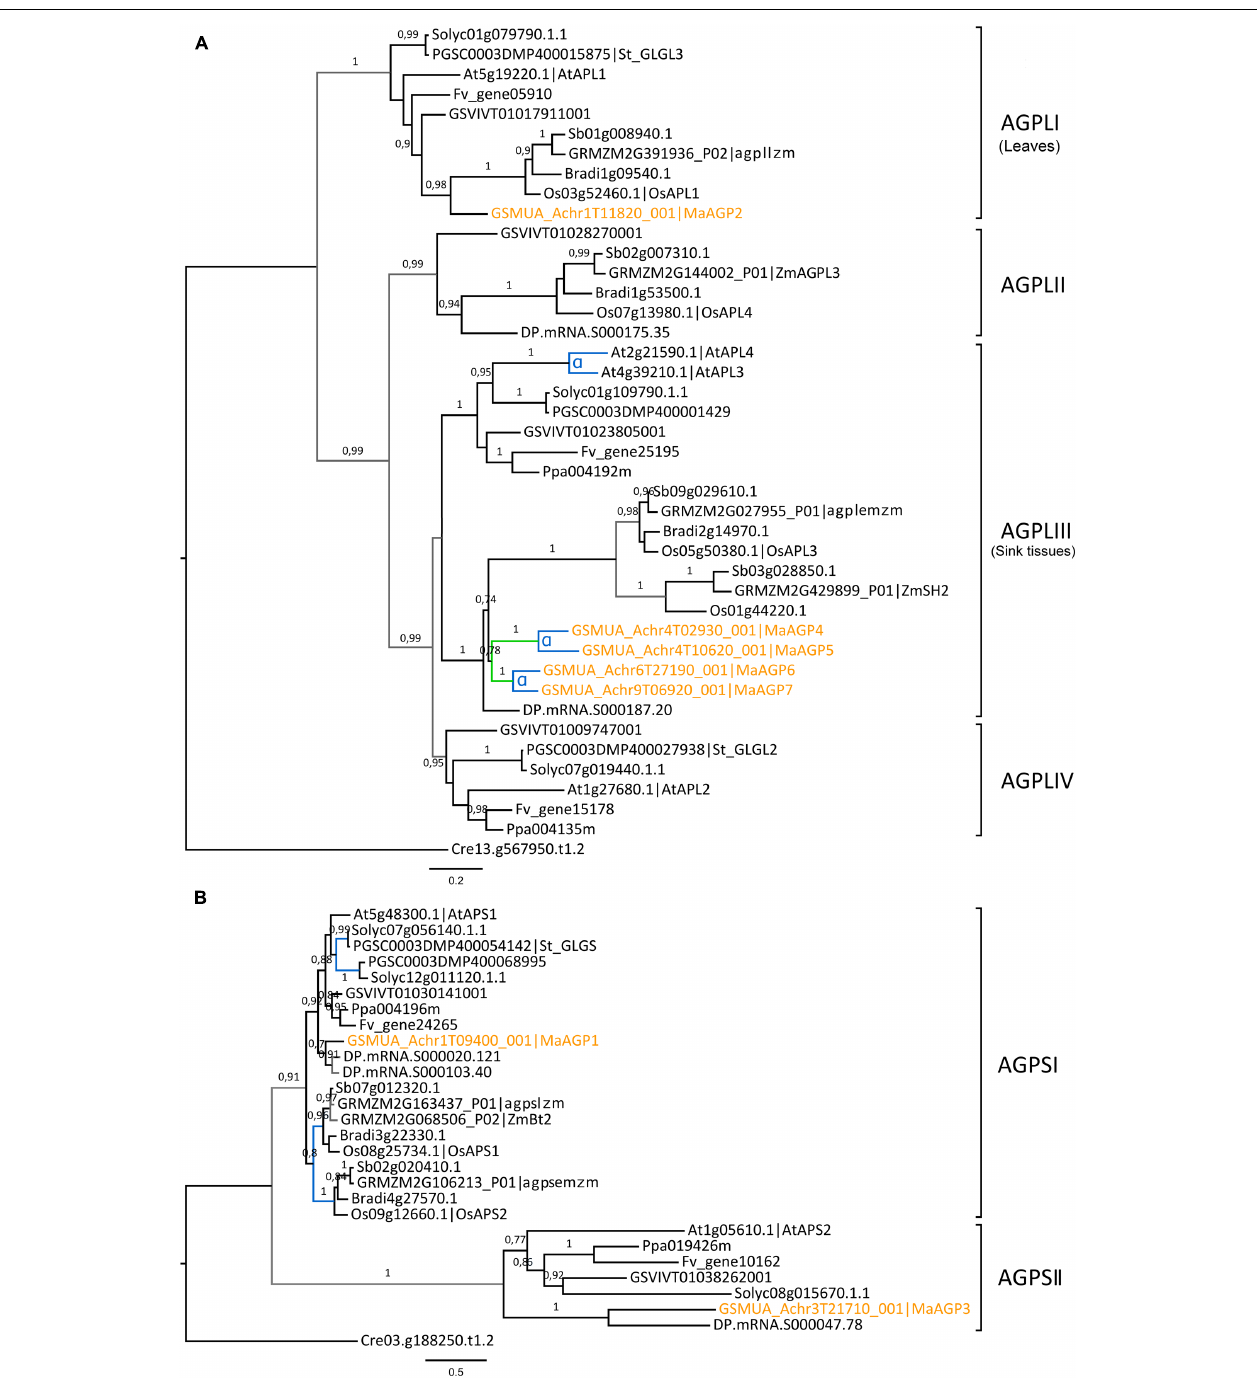
FIGURE 1 | Phylogenetic trees of the AGPase family. (A) Maximum likelihood tree of AGPase large subunit predicted proteins (AGPL, 42 sequences). (B) Maximum likelihood tree of AGPase small subunit predicted proteins (AGPS, 28 sequences). Trees were rooted using a Chlamydomonas reinhardtii (Cre) AGPase sequence. The different subclades are indicated on the right. Branch supports > 0.70 (aLRT statistics with SH–like procedure) are indicated. Chlamydomonas reinhardtii (Cre), Grapevine (GSVIV), tomato (Solyc), potato (PGSC), woodland strawberry (Fv), Arabidopsis (At), peach (Ppa), Brachypodium (Bradi), rice (Os), maize (GRMZM), Sorghum (Sb), date palm (DP) and banana (Ma) identifiers are indicated (in brown for banana). Maize genes nomenclature is based on Huang et al. (2014). Branches are colored according to gene duplication modes: WGD (blue), segmental (green) and unknown (gray). WGD events identified using reconstructed ancestral blocks are indicated (blue letters). Black branches correspond to speciation events. The scale bar represents the estimated amino acid substitutions per site. AGPLI genes are mainly expressed in leaves whereas AGPL genes from other groups are mainly expressed in sink tissues (Corbi et al., 2012).